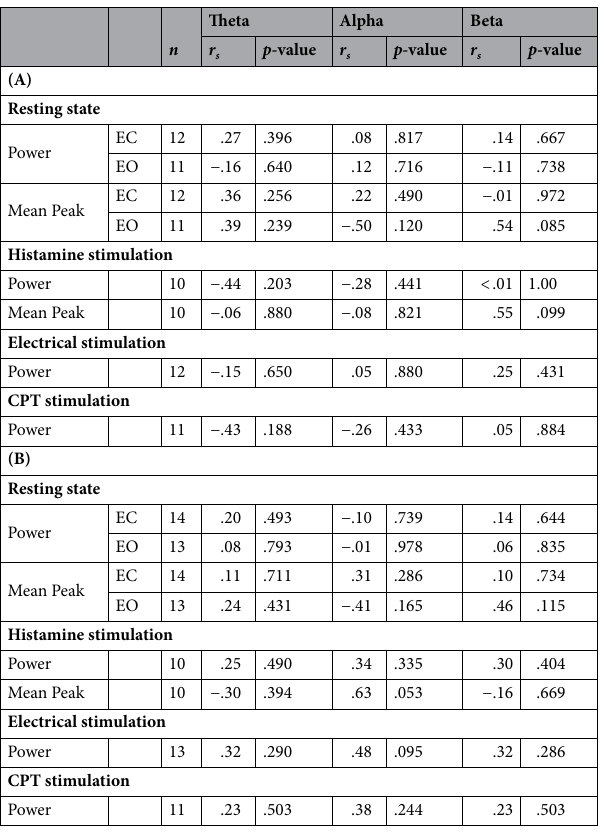
Table 7. Spearman’s correlation coefficient ( r s ) between power and mean peak frequencies during rest, with eyes closed (EC) or eyes open (EO), and stimulation states in theta, alpha, and beta frequency bands